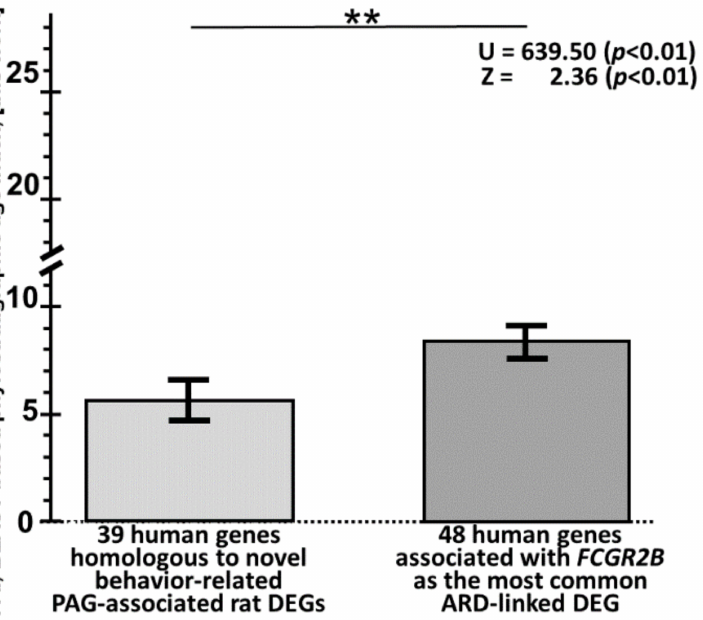
Figure 6. A comparison between 48 human FCGR2B -associated genes using the publicly available toolbox ANDSystem [227] (Figure 5) and the human genes homologous to 39 novel PAG-related rat DEGs (Table 2). Legend : the double asterisk (i.e., double character “**”) denotes statistical significance at p < 0.01 according to nonparametric Mann–Whitney U test and parametric Fisher’s Z-test; PAI, a gene’s phylostratigraphic age index evaluated against the BLAST-based scale [232] using the